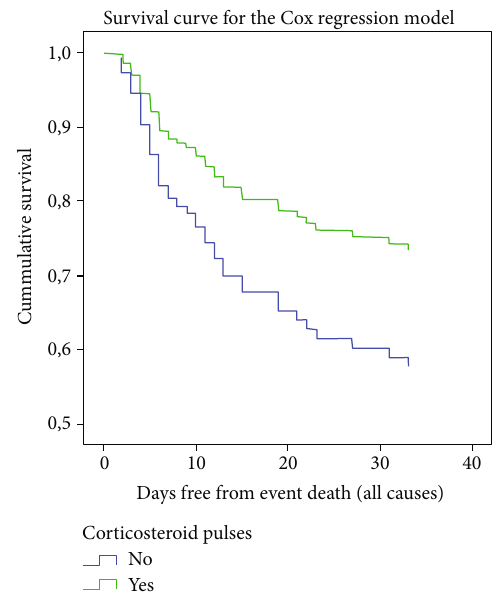
Figure 4: Survival for the Cox regression model in corticosteroids exposed and nonexposed patients (in the PSM